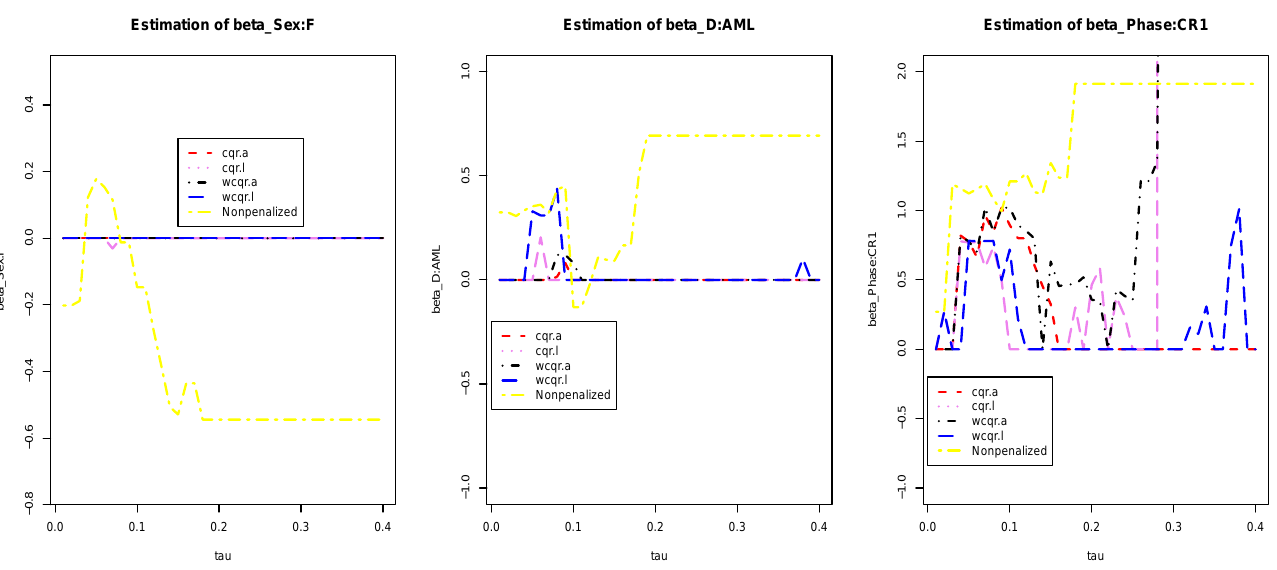
Figure 3. Variable selection and estimation results for intercept and β Age . The Y axis reports the coefficient values at different τ . Various colors of lines represent eight methods.